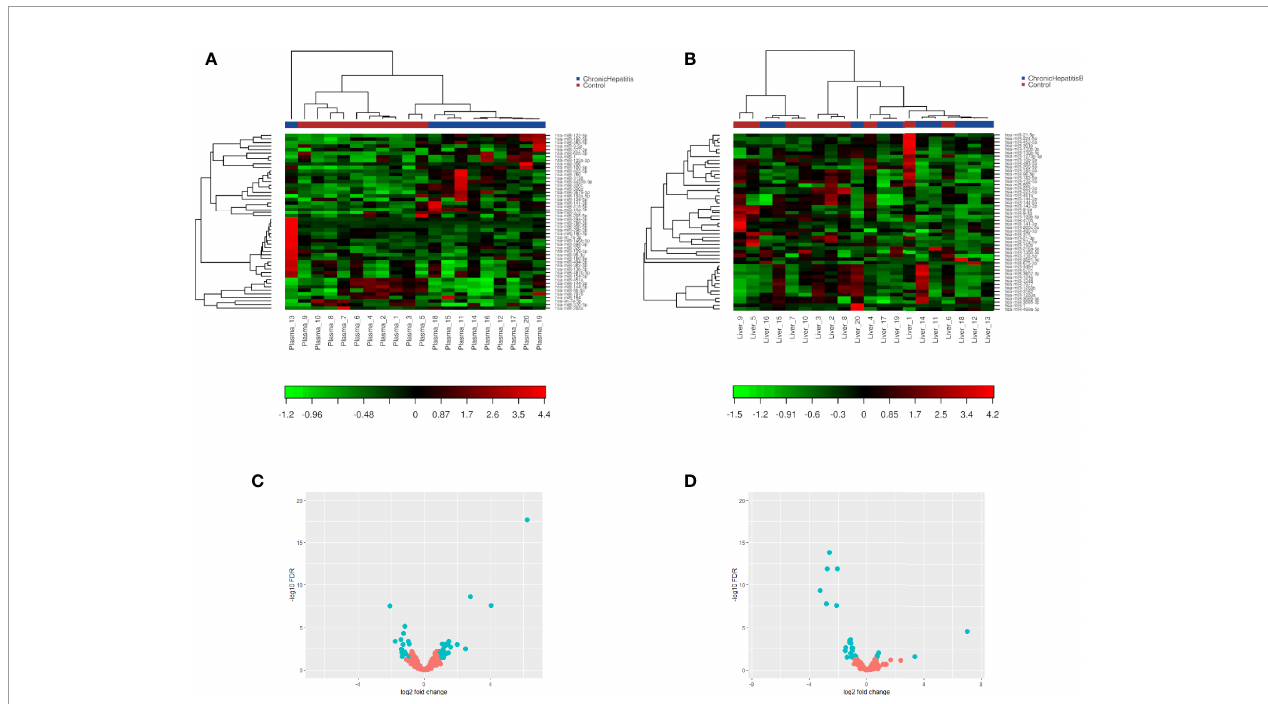
FIGURE 2 | Two-way hierarchical clustering analysis and volcano plot of identi fi ed plasma and liver tissue miRNA. miRNA/small RNA NGS was performed using total RNA isolated from matching plasma (n=10) and liver biopsies(n=10) of the identi fi cation cohort. A heatmap of plasma (A) or liver (B) expression pro fi les was generated and a two-way hierarchical clustering analysis was performed using TMM normalized quanti fi cations from de fi ned collections of samples as input. Red represents an expression level above the mean and green below the mean. Volcano plot of differentially expressed miRNAs between CHB patients and controls in plasma (C) and liver tissue (D) samples. miRNAs that pass the cut-off criteria (FDR ≤ 0.05 and FC± 1.8 for plasma or FC± 1.5 for liver) are shown in